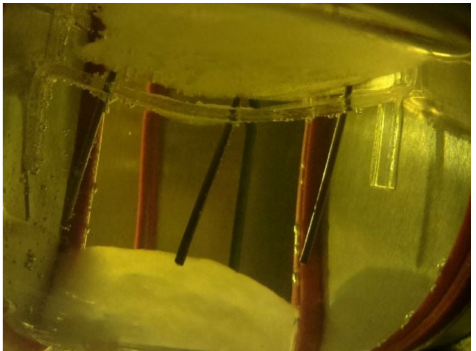
Figure 21. Visual observation of phase separation of a solid–liquid PCM in the device